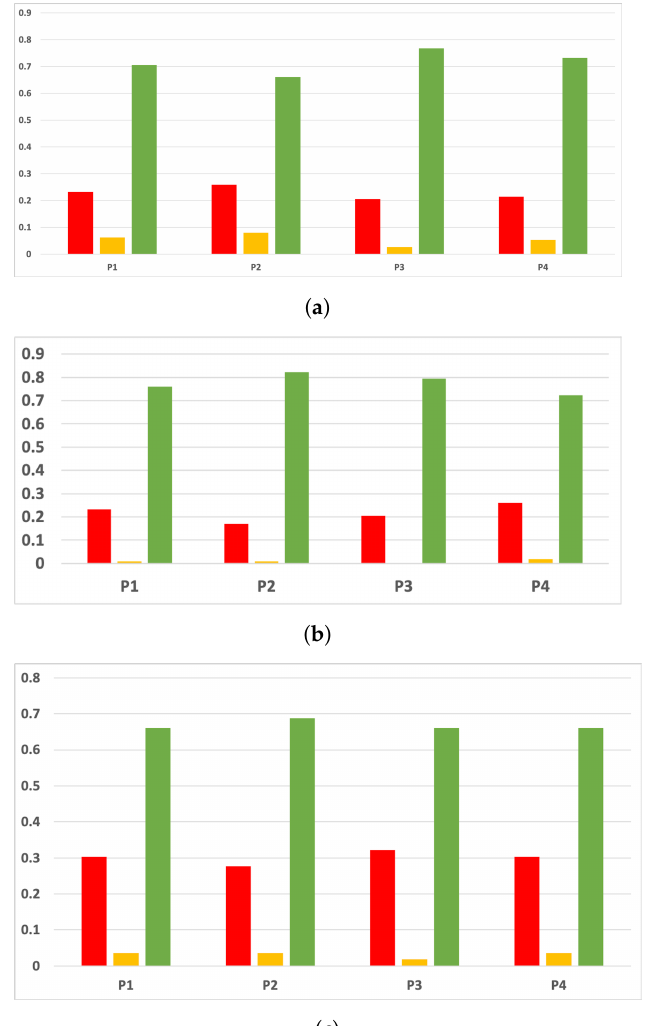
Figure 16. Experiment 1: consistency per partition (accuracy and time complexity). ( a ) Rate of validity per partition in RF. In axis X, the partition of the dataset. In axis Y, the rate of RHOASo for each class of validity. ( b ) Rate of validity per partition in GB. In axis X, the partition of the dataset. In axis Y, the rate of RHOASo for each class of validity. ( c ) Rate of validity per partition in MLP. In axis X, the partition of the dataset. In axis Y, the rate of RHOASo for each class of